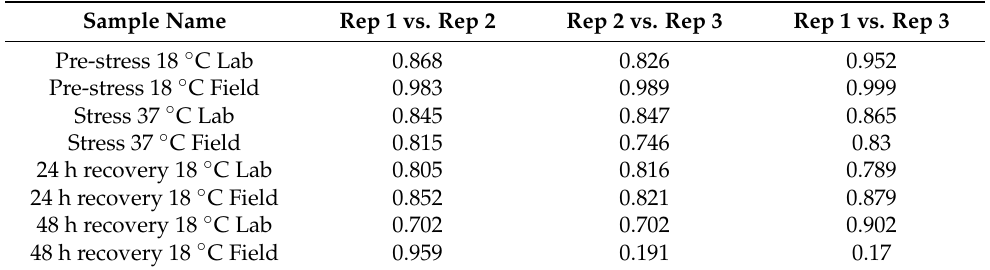
Table 2. Pearson correlation (R 2 ) results * of pairwise comparisons between replicates in each treatment.